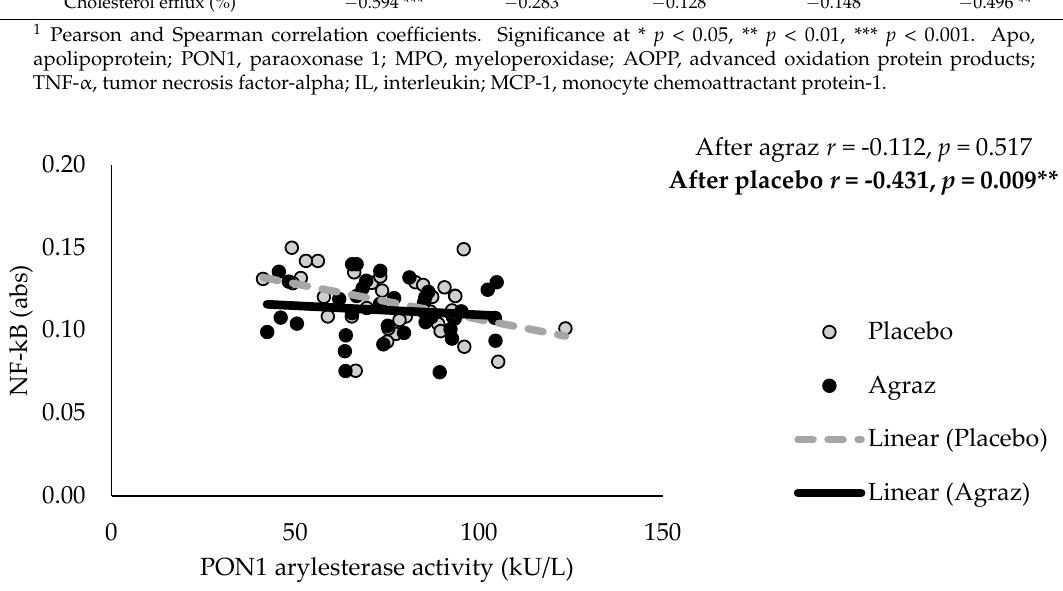
Figure 4. Pearson correlation between nuclear factor kappa B (NF-κB) and paraoxonase 1 (PON1) after agraz consumption, compared to placebo. Significance ** p < 0.01.